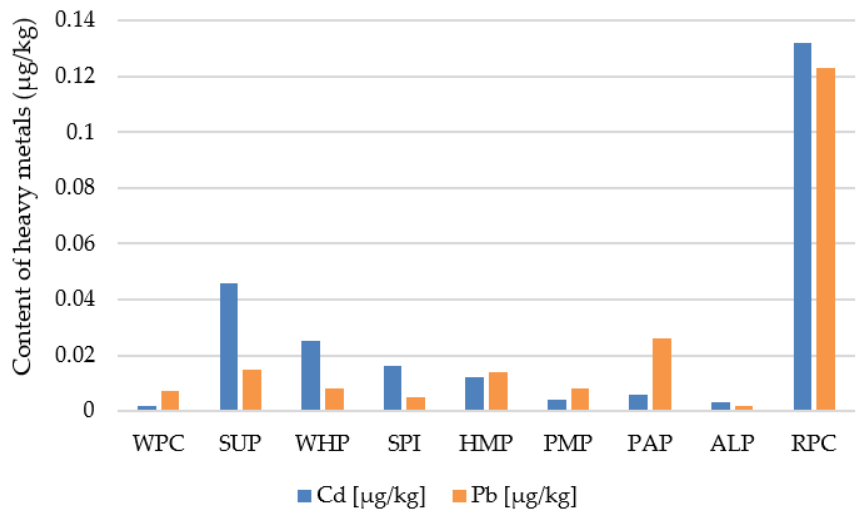
Figure 4. Content of heavy metals (cadmium and lead) in the high-protein bars.